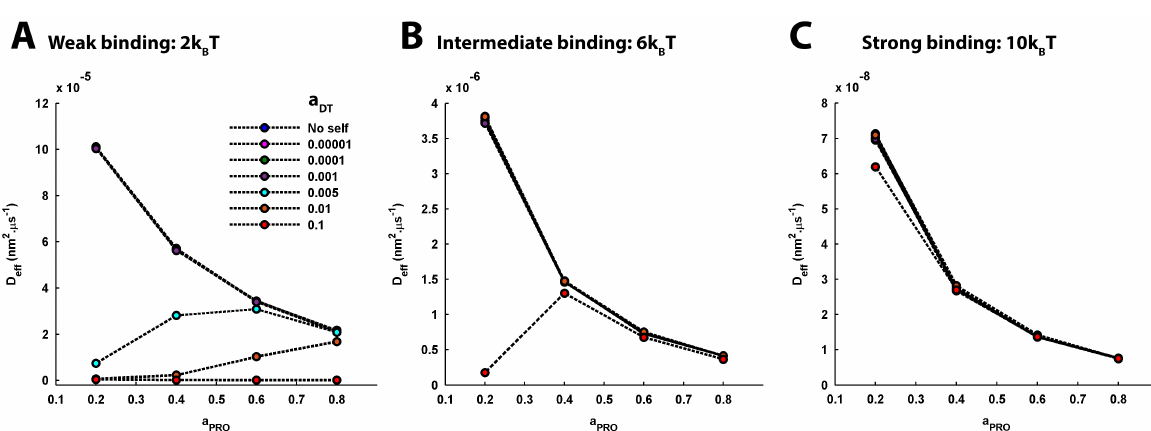
Fig 8. The effect of varying DT-PRO binding energy and PRO density on the effective diffusion coefficient of tracer diffusion, under different self-crowding conditions. (A) Weak DT-PRO binding. For the no-self-crowding condition and self-crowding conditions with a (cid:20) DT 0.001, the effective diffusion coefficient, D , of tracer diffusion appears to consistently decrease with increase in a and their profiles also fairly eff PRO overlap with each other. For a DT = 0.005, D eff initially rises with increase in a PRO and closely approaches the D eff for lower a DT at a PRO = 0.6. Subsequently, following the D profile for lower a , it decreases with further increase in a . For a = 0.01, D gradually rises with increase in eff DT PRO DT eff a PRO and closely approaches the profile of variation in D eff for lower a DT by a PRO = 0.8. The rise in D eff observed here with rising a PRO is owing to the associated reduction in anomalousity and confinement of tracer diffusion. However, for a = 0.1, D remains significantly low across the DT eff entire span of a PRO . (B) Intermediate DT-PRO binding. D eff appears to consistently decrease with increase in a PRO for the no-self-crowding condition and self-crowding conditions with a (cid:20) 0.01. However, for a = 0.1, D sharply rises with increase in a and closely approaches the DT DT eff PRO profile of variation in D for lower a by a = 0.4. Further increase in a leads to gradual decrease in D . (C) Strong DT-PRO binding. D eff DT PRO PRO eff eff consistently decreases with increase in a PRO for the no-self-crowding condition as well as all values of a DT . Further, the profiles of the variations in D eff are sufficiently overlapping. (A-C) It is evident that the scale of the magnitude of D eff significantly decreases with increase in the DT-PRO binding energy. Accordingly, increase in binding, either through increase in binding energy or PRO density or both, in general leads to reduction in tracer mobility. Only for the conditions of self-crowding where increase in binding leads to reduction in anomalousity of tracer diffusion, one may observe a relative increase in D eff